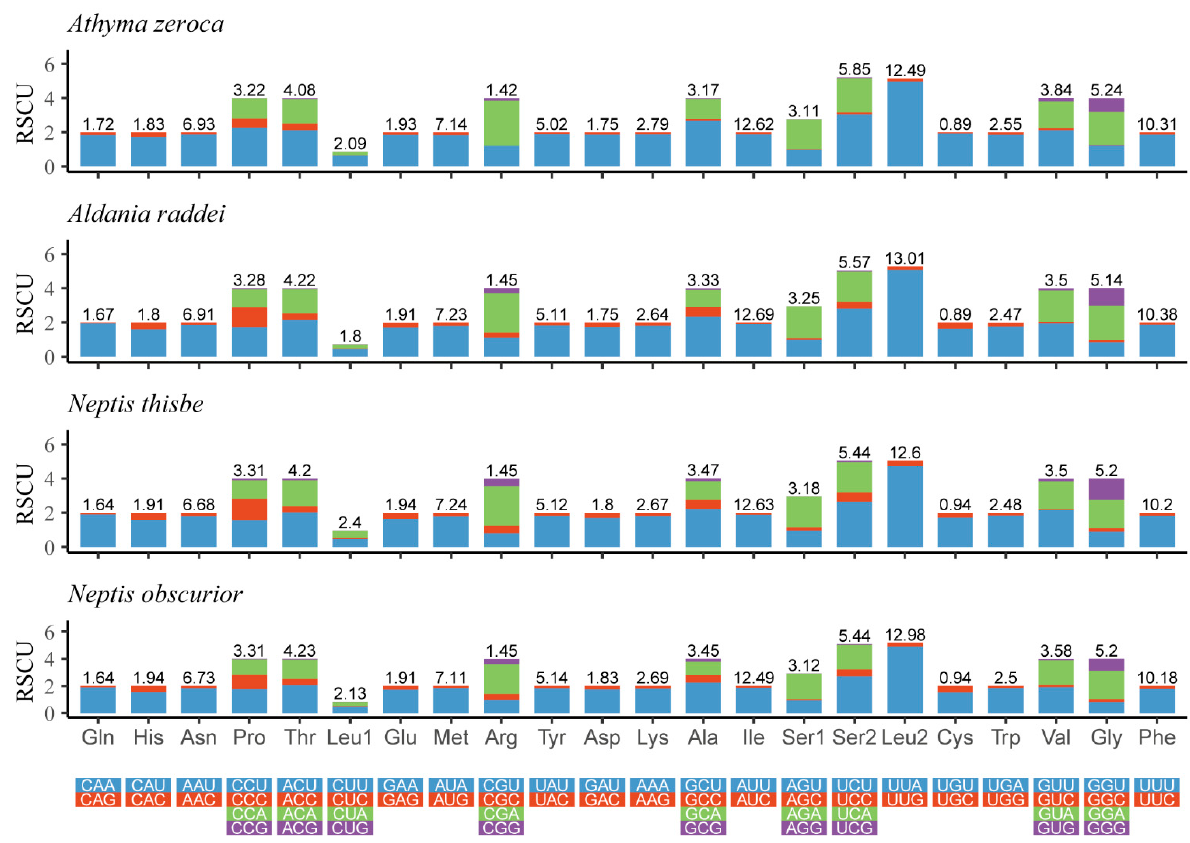
Figure 2. Relative synonymous codon usage (RSCU) of the mitogenomes of four Limenitidinae species. The ordinate represents the RSCU (the number of times a certain synonymous codon is used/the average number of times that all codons encoding the amino acid are used). The abscissa represents different amino acids. The number above the bar graph represents the ratio of amino acids (number of certain amino acids/total number of all amino acids). Termination codons were excluded in the study.